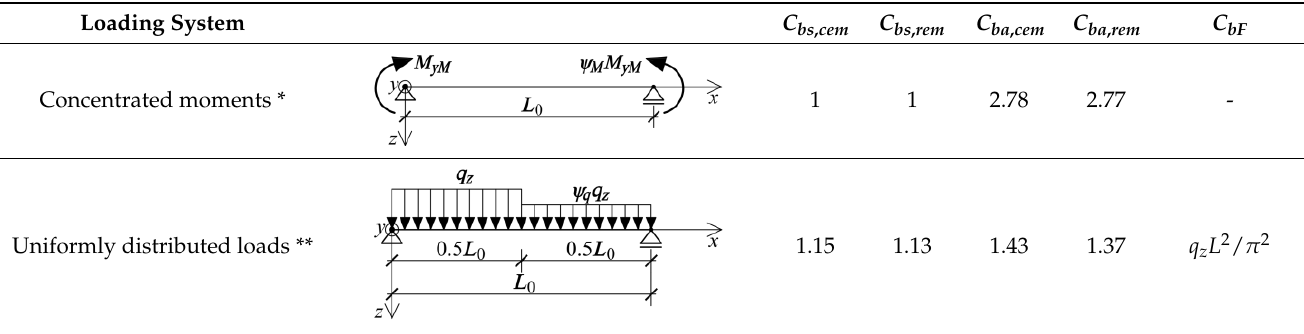
Table 1. Equivalent uniform moment-modification-factors for non-uniform bending under symmetric and antisymmetric components of asymmetric-loading systems.